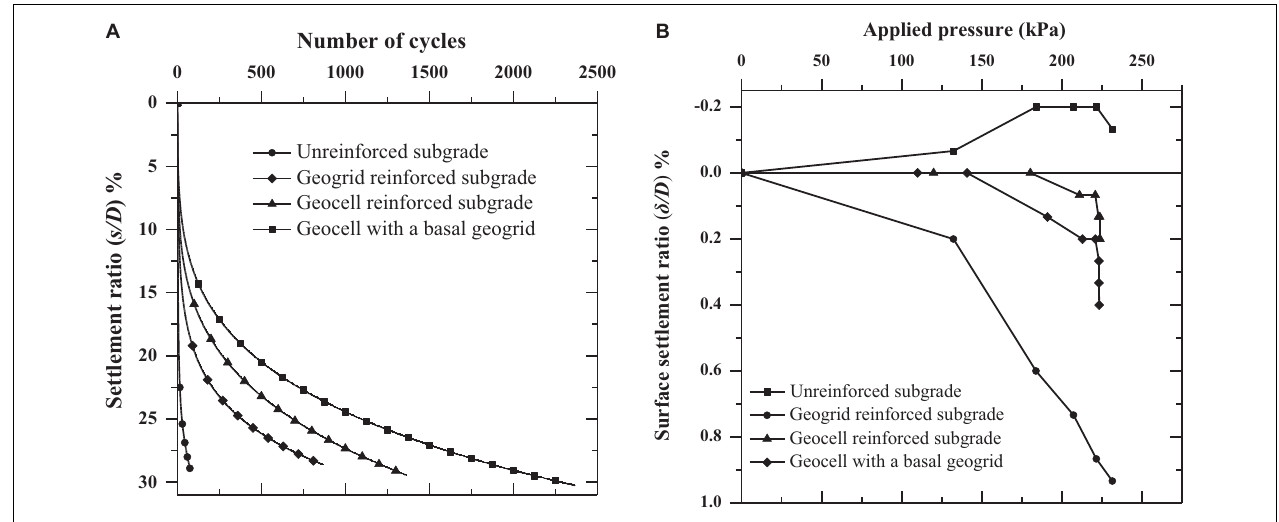
FIGURE 6 | Test results: (A) variation of settlement ratio with the number of cycles; (B) variation of soil surface settlement with applied